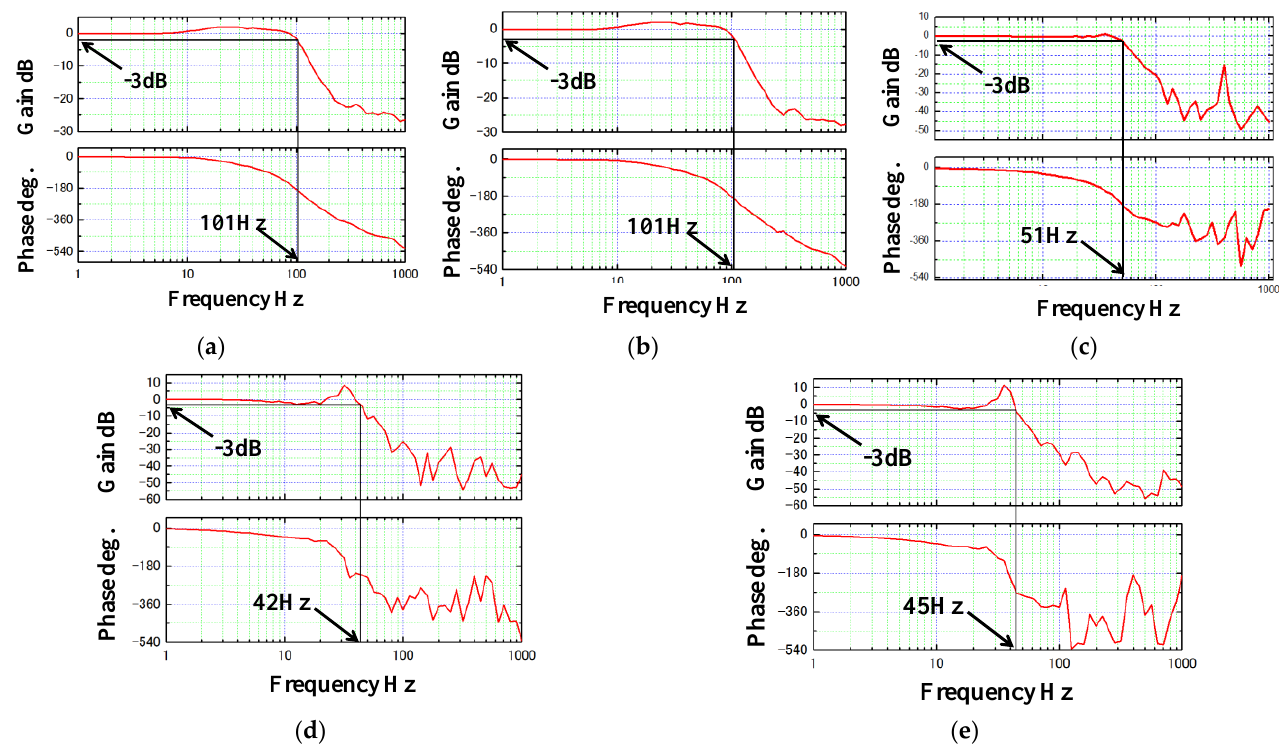
Figure 16. Frequency responses. ( a ) The bandwidth in the X direction; ( b ) The bandwidth in the Y direction; ( c ) The bandwidth in the Z direction; ( d ) The bandwidth in the Φ direction; ( e ) The bandwidth in the θ direction. Table 3. Performance evaluation results table.